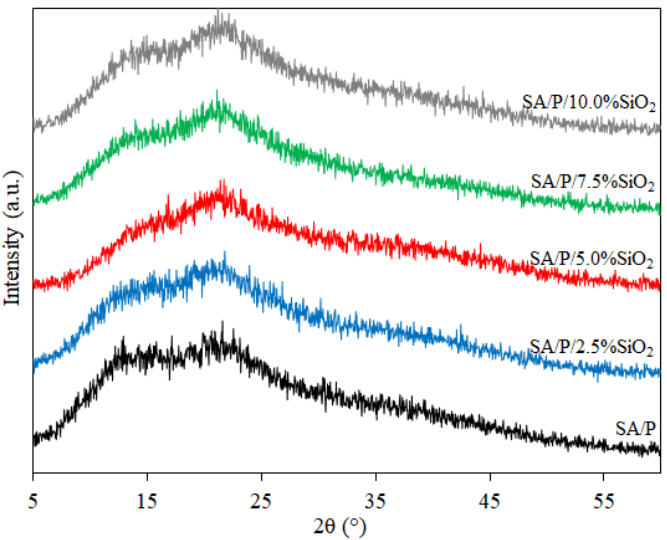
Figure 3. XRD patterns of SA/P and SA/P/SiO 2 films.